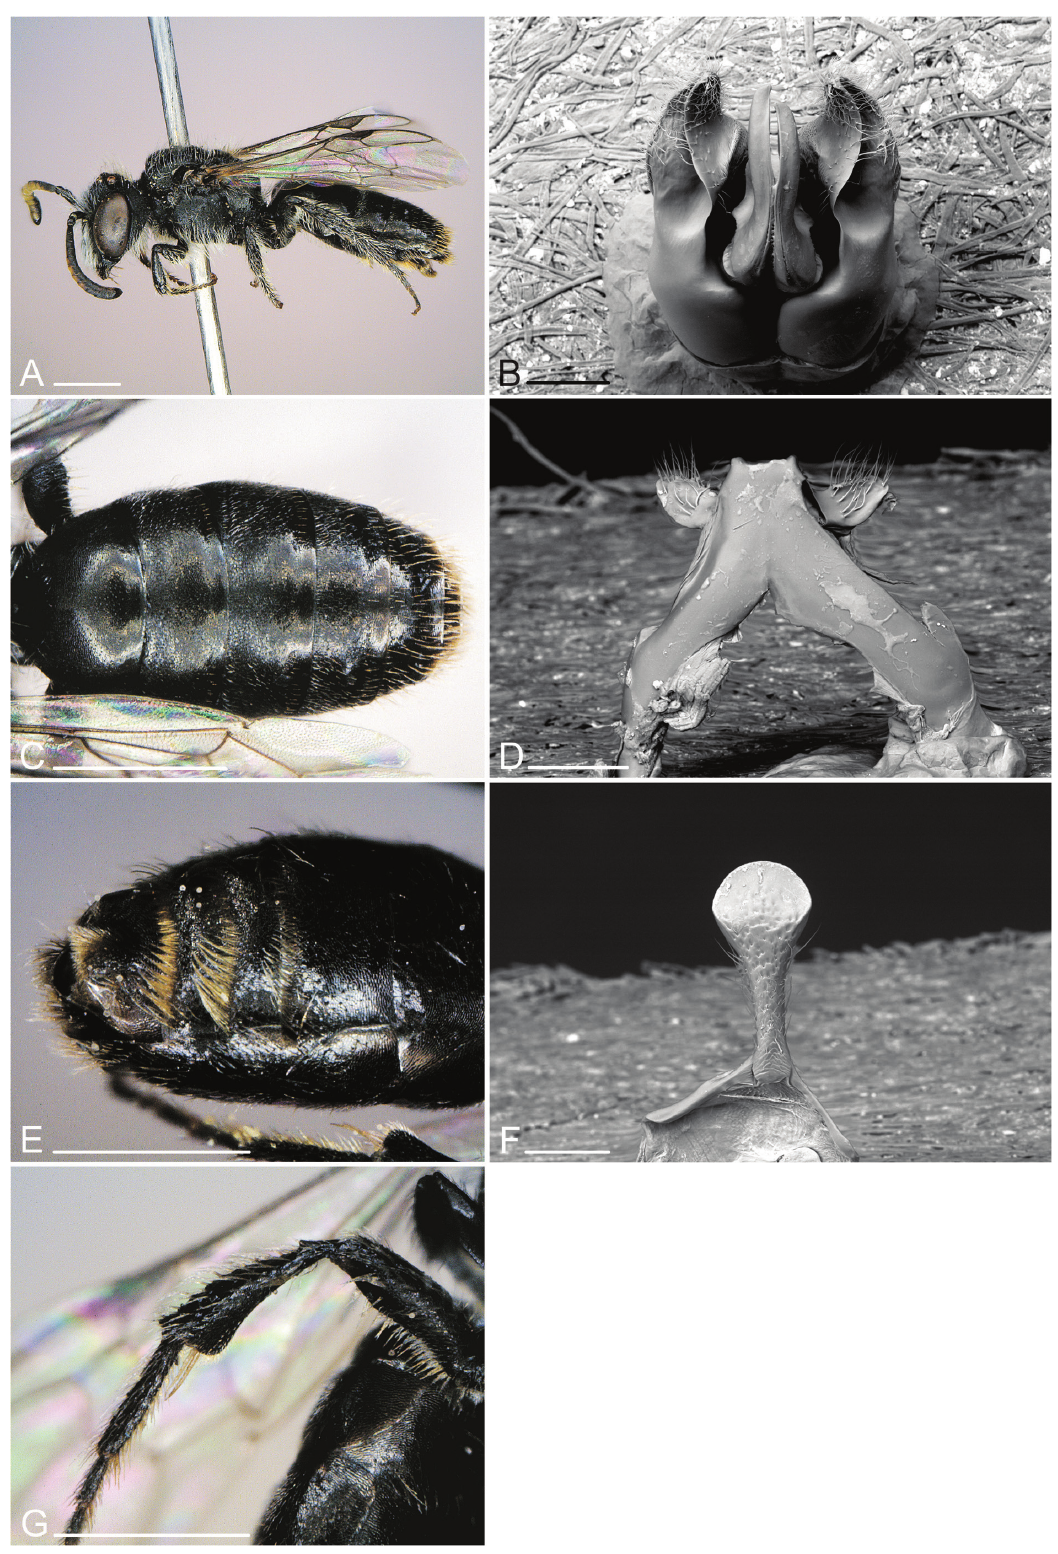
Fig. 27. Scrapter roggeveldi sp. nov., ♂. A . Lateral view. B . Genitalia (dorsal view, SEM). C . Metasoma (dorsal view). D . S7 (dorsal view, SEM). E . Metasoma (ventral view). F . S8, apical end (SEM). G . Hind tibia. Scale bars: photos: 1 mm, SEM: